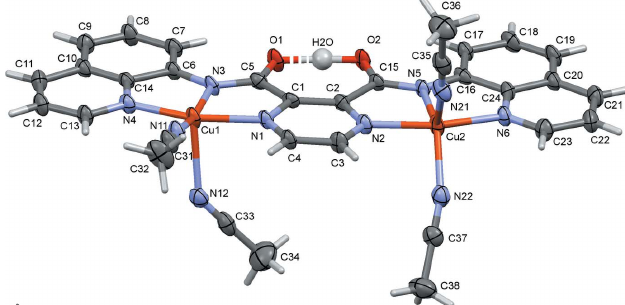
Figure 1 Molecular structure of ligand H 2 L1 , with atom labelling. Displacement ellipsoids are drawn at the 50% probability level. The intramolecular contacts are shown as dashed lines (see Table 1).